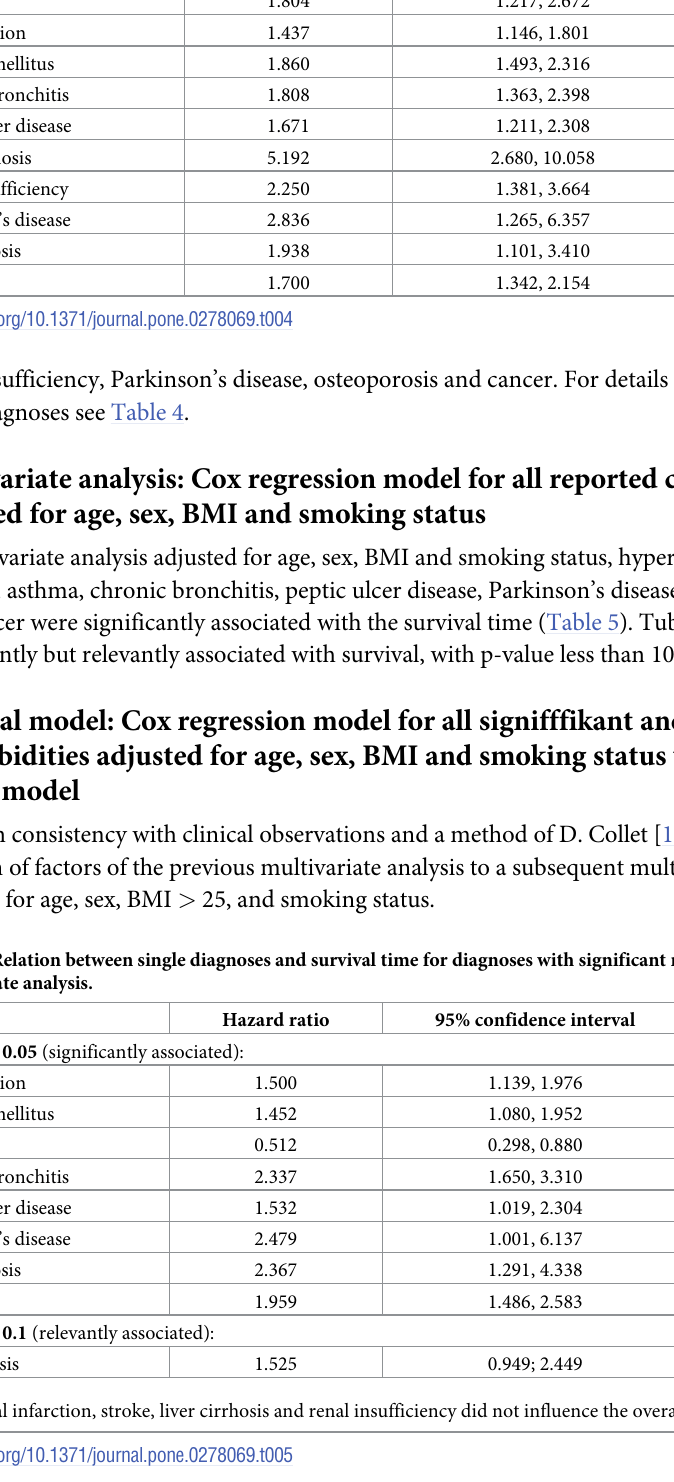
Table 4. Relation between single diagnoses and survival time, adjusted for age and sex. Diagnosis Hazard ratio 95% confidence interval